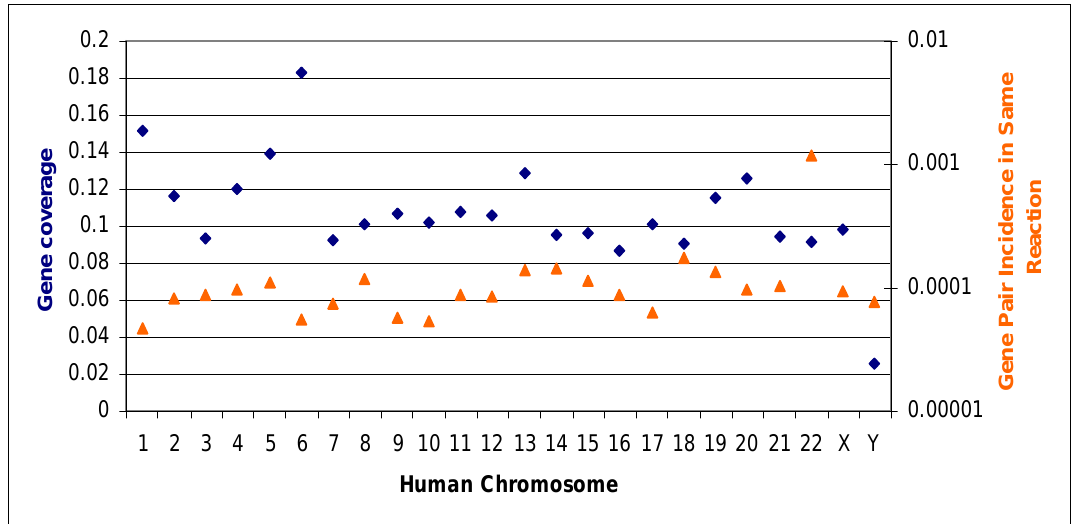
Figure 5: Examples of integrated genome-pathway analyses. For every human chromosomal gene set: (a) the number of genes mapped to Reactome Physical Entities in relation to the total number of genes per chromosome in Ensembl (left Y axis, dark blue), (b) incidence index of a pair of gene products from the same chromosome involved in the same Reaction (right Y logarithmic axis,